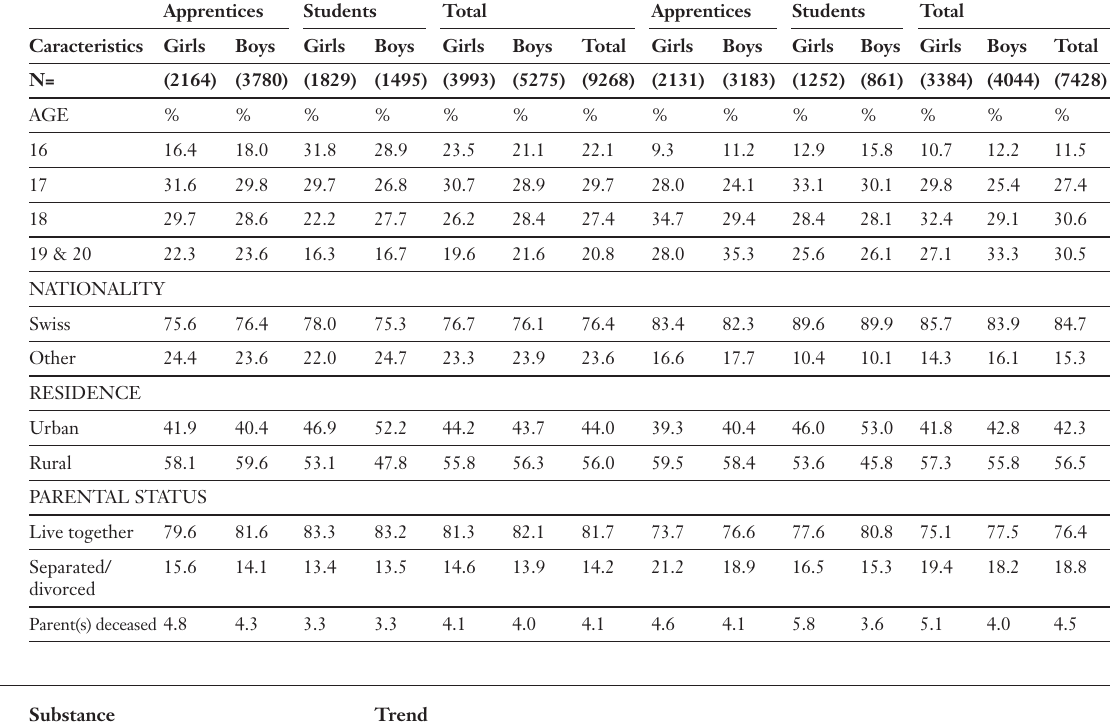
Magnitude of differences in trends, by gender and by gender and academic